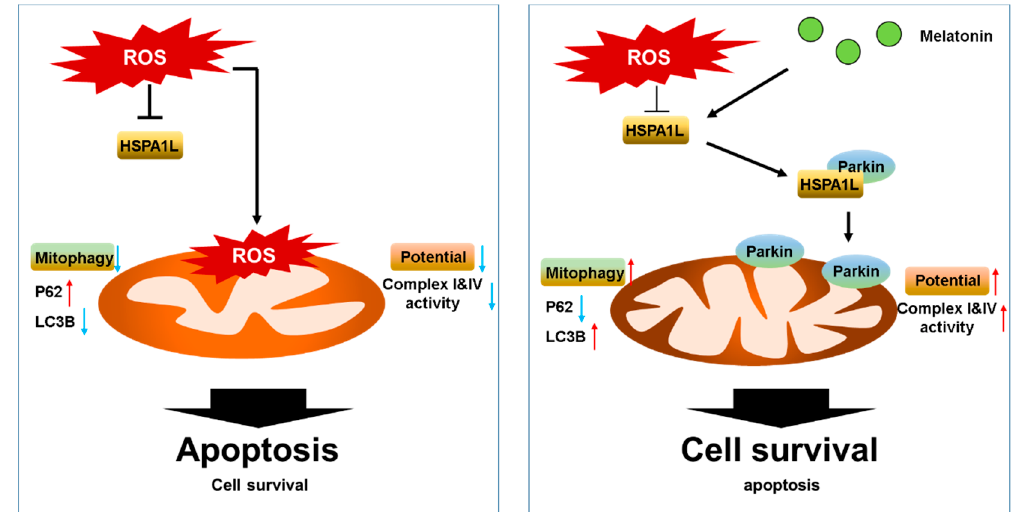
Figure 7. Schematic shows melatonin-induced resistance to oxidative stress (left), and how treatment with melatonin restored mitochondrial function by increasing the expression of HSPA1L and stabilizing parkin in hMSCs subjected to oxidative stress. Oxidative stress induces mitochondrial dysfunction by decreasing mitophagy, which results in accumulation of abnormal mitochondria. Melatonin-treated hMSCs increase their expression of HSPA1L, which stabilizes parkin-induced mitophagy and helps eliminate dysfunctional mitochondria; this cascade also increases mitochondrial membrane potential and decreases apoptosis in hMSCs placed under oxidative stress.